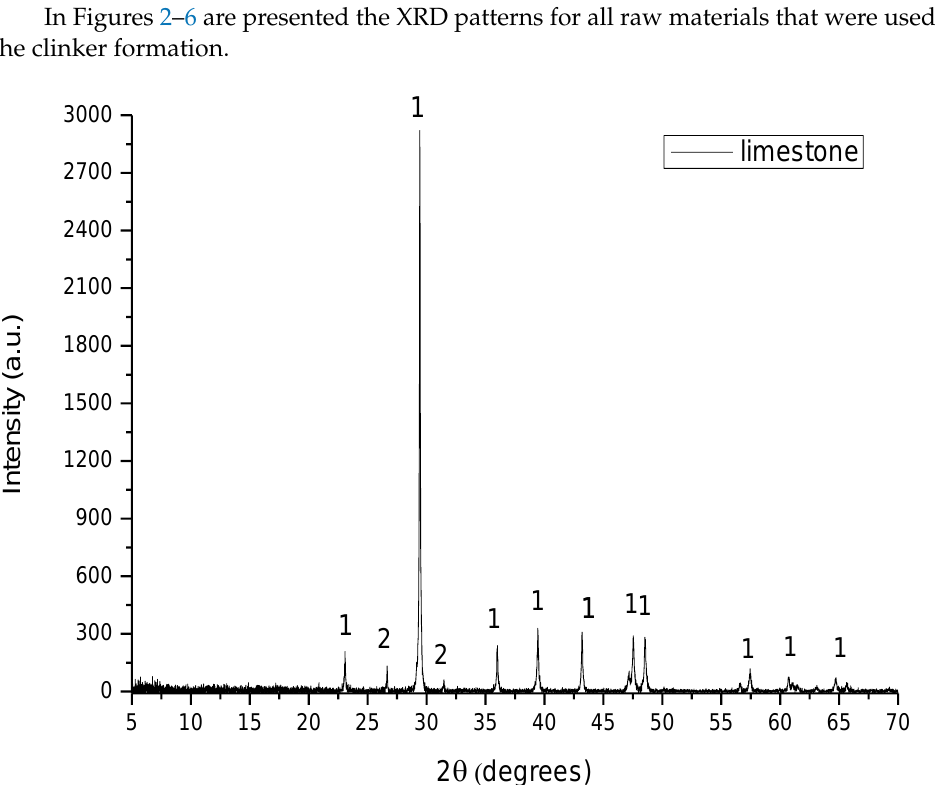
Table 1. XRF analysis and LOI of raw materials.